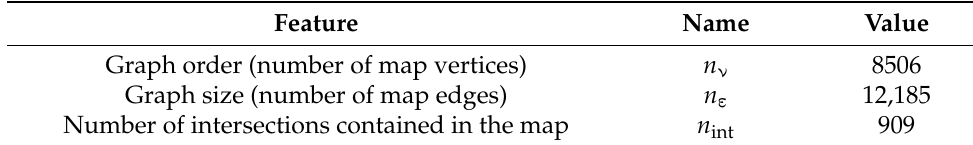
Table 1. Shown is a summary of the road infrastructure description of the Lyft database. Table 1. Summary of the road infrastructure description of the Lyft